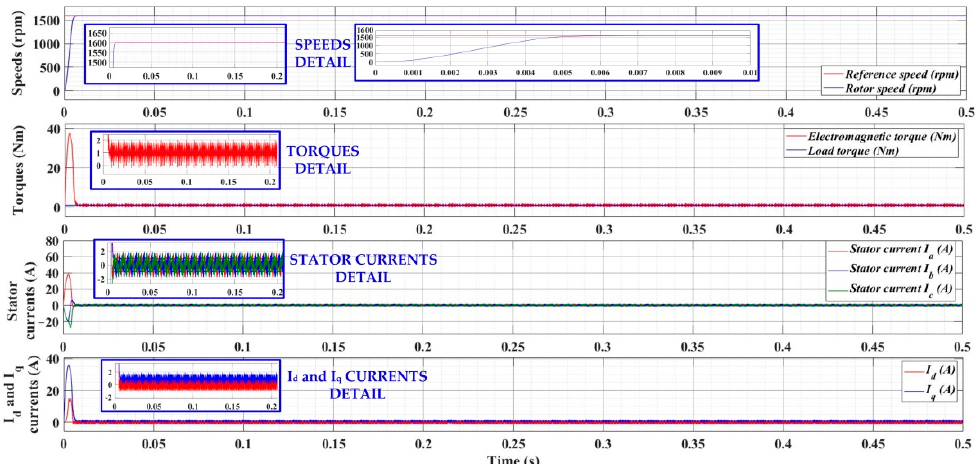
Figure 3. Time evolution for the numerical simulation of the PMSM control system based on the PI-PSO speed controller: ω ref = 1600, T L = 1 Nm, K p = 1.69, and K i = 1.56. If the variation of the load torque is between 1 Nm and 4 Nm, at time 0.25 s after